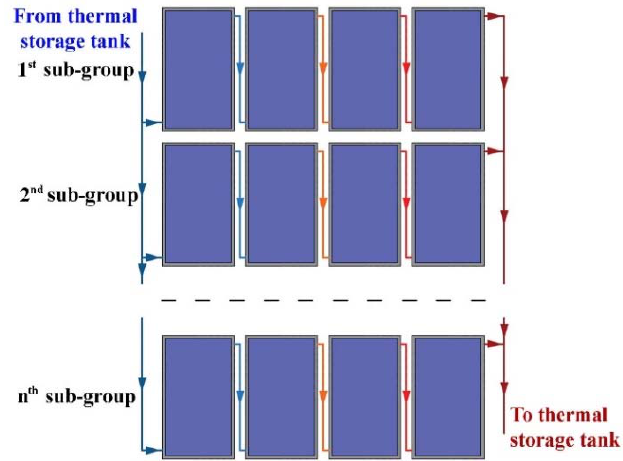
Figure 12. Connection layout of the solar collectors’ field. The TRNSYS simulation model was also utilized for the determination of the optimum installation angle of the solar collectors versus the horizontal plane. This was executed aiming at the maximisation of the thermal energy production during the winter period (from the 1st of November to the 31st of March) and for the geographical latitude of the under consideration location (35°). By executing similar simulations of the solar collectors’ performance under alternative installation angles with an increment step of 5°, it was concluded that the optimum installation angle is 45 ο . Obviously the solar collectors are oriented to the south (collectors’ surface azimuth angle equal to 0°). For this optimum installation angle and orientation, the annual variation of the total incident solar radiation (direct, diffused and reflected) per unit of solar collectors’ surface (in W/m 2 ) is depicted in Figure 13. The simulation process is based on the following essential steps: The simulation is executed on hourly, average calculation time steps.